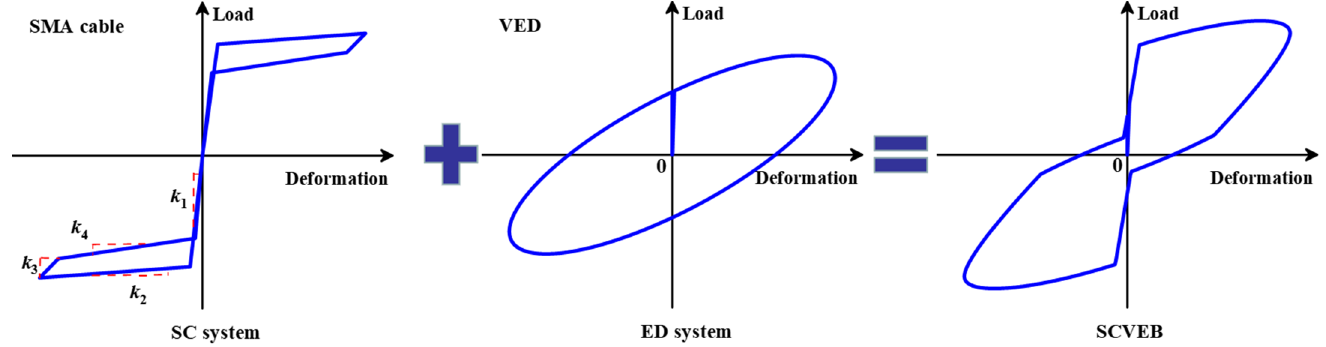
Figure 4. Typical hysteretic behavior of